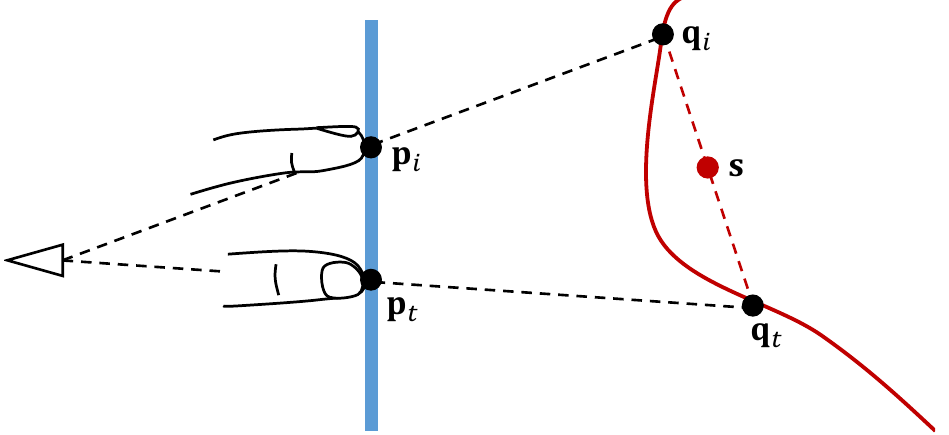
Figure 3. For handle selection, the 2D positions of the thumb and index on the touchscreen ( p t and p i , respectively) are mapped to 3D positions ( q t and q i , respectively) through isosurface raycasting. The selection is initialized at the seed s